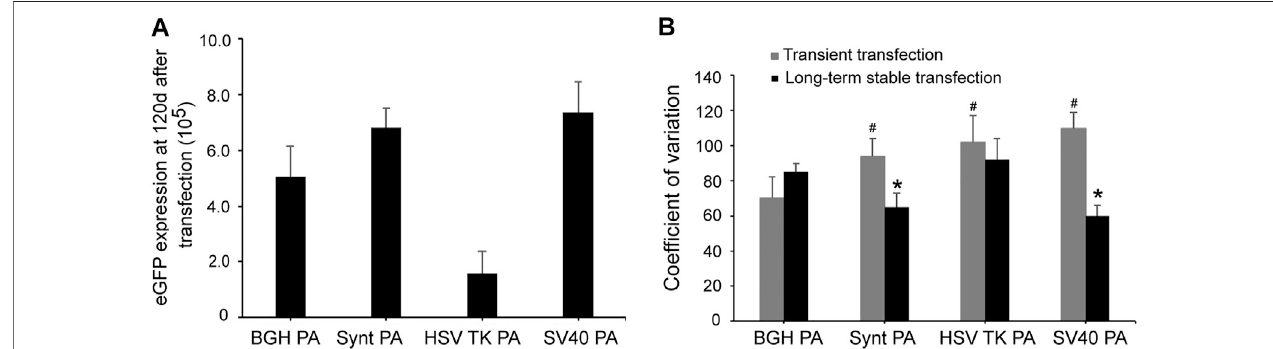
FIGURE 4 | (A) Long-term eGFP expression stability in transfected CHO cells. Cells were collected, and FACSCalibur estimated the eGFP fl uorescence pro fi le at 120 days after transfection. (B) The CV of transient expression and long-term stable expression of eGFP. CV values are expected to re fl ect variations in transgene expression. The gray bar represents CV of temporary transfection cells of eGFP that were tested at 48 h post-transfection. The black bar represents CV of stable transfection cells of eGFP at 120 days after transfection. The results are the mean values obtained for three independent experiments, and standard deviation is indicated. Compared with BGH poly A, p < 0.05.